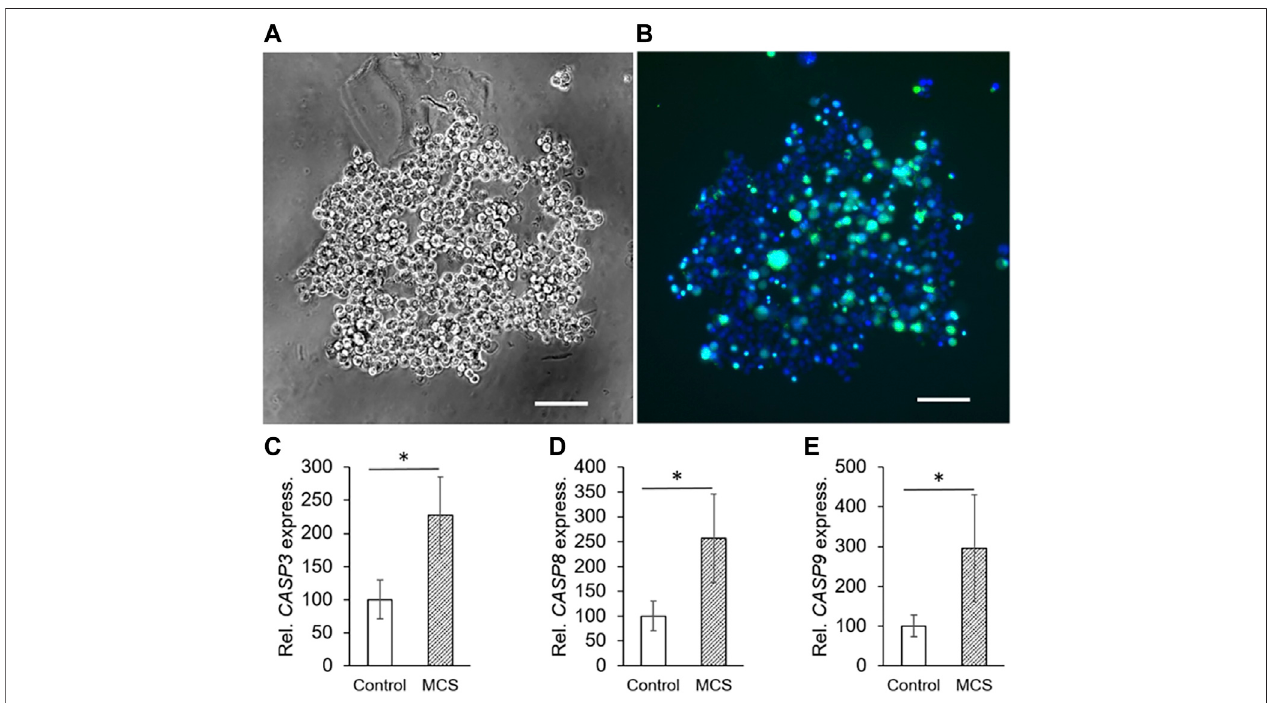
FIGURE2| PhasecontrastmicroscopyofPC-3cells: (A) static1 g- MCSafter24 husingtheliquidoverlaytechnique(scalebar100 µm)and (B) samesampleusing the live cell viability assay, where the blue color indicates the nuclei of all cells while the green color demonstrates compromised cells. (C,D,E) The CASP3, CASP8 and CASP9 (24 h) gene expression was signi fi cantly altered in 1 g -MCS after 24 h (n = 5).